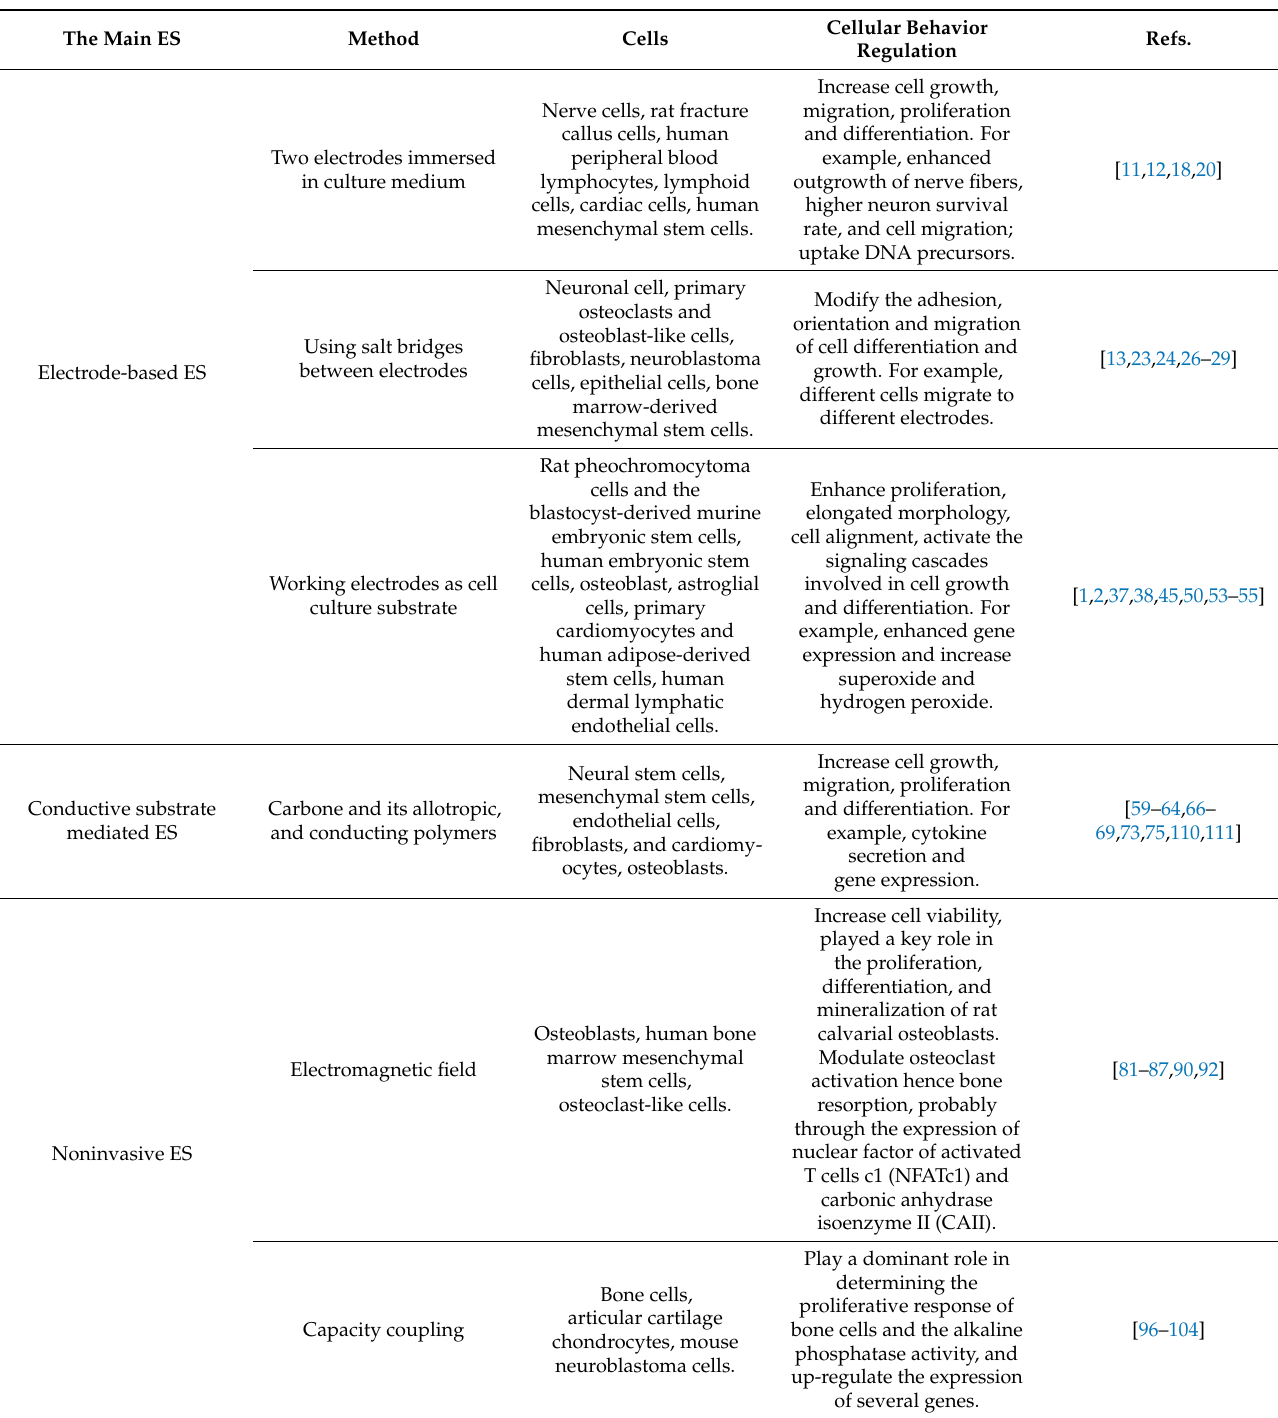
Table 1. Electrical stimulation regulated cells and cellular